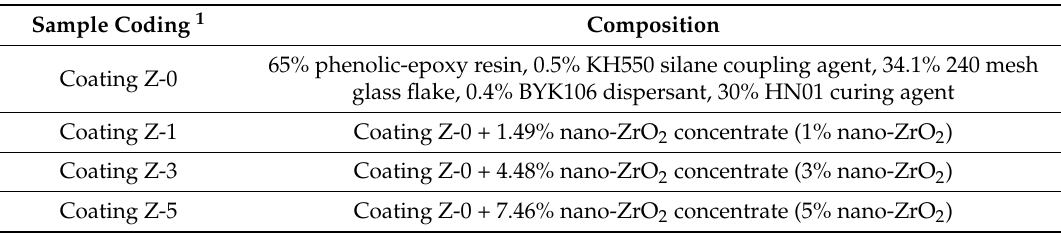
Table 1. Composition of